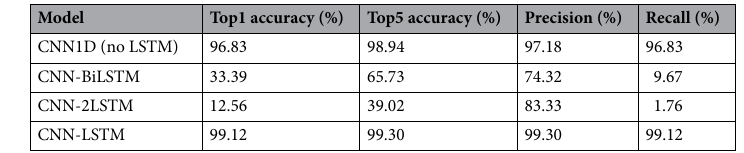
Table 2. The table compares the performance using different or no LSTM architectures. The bold values indicate the results from our proposed model for the processed and raw spectra.